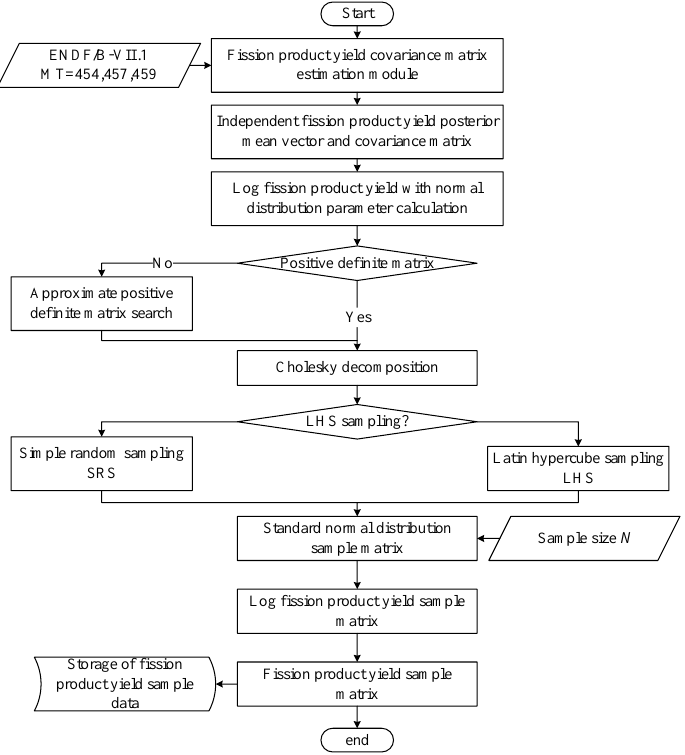
Figure 3. Independent fission product yield log-normal based distribution-based sampling proce-